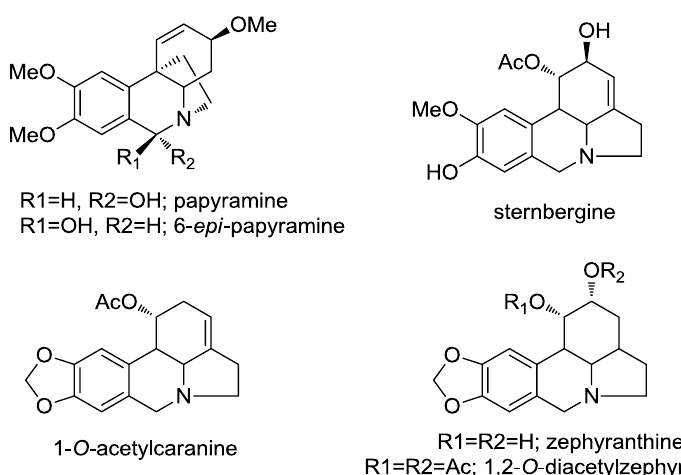
Figure 2. Alkaloids allowing the structural elucidation of compounds 1 – 4 .